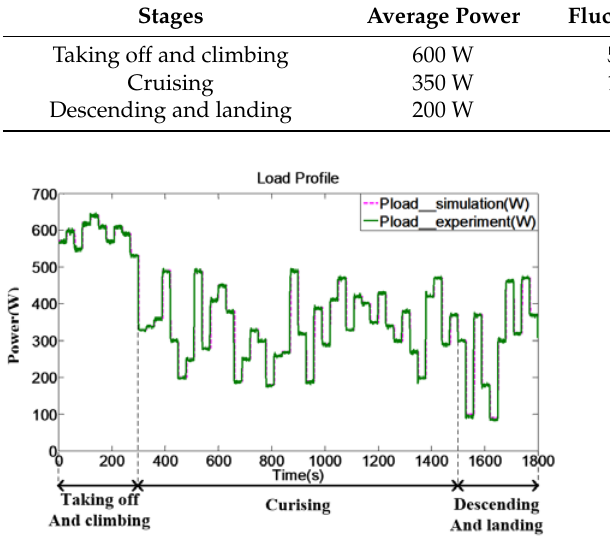
Figure 17. The power profile of the UAV.